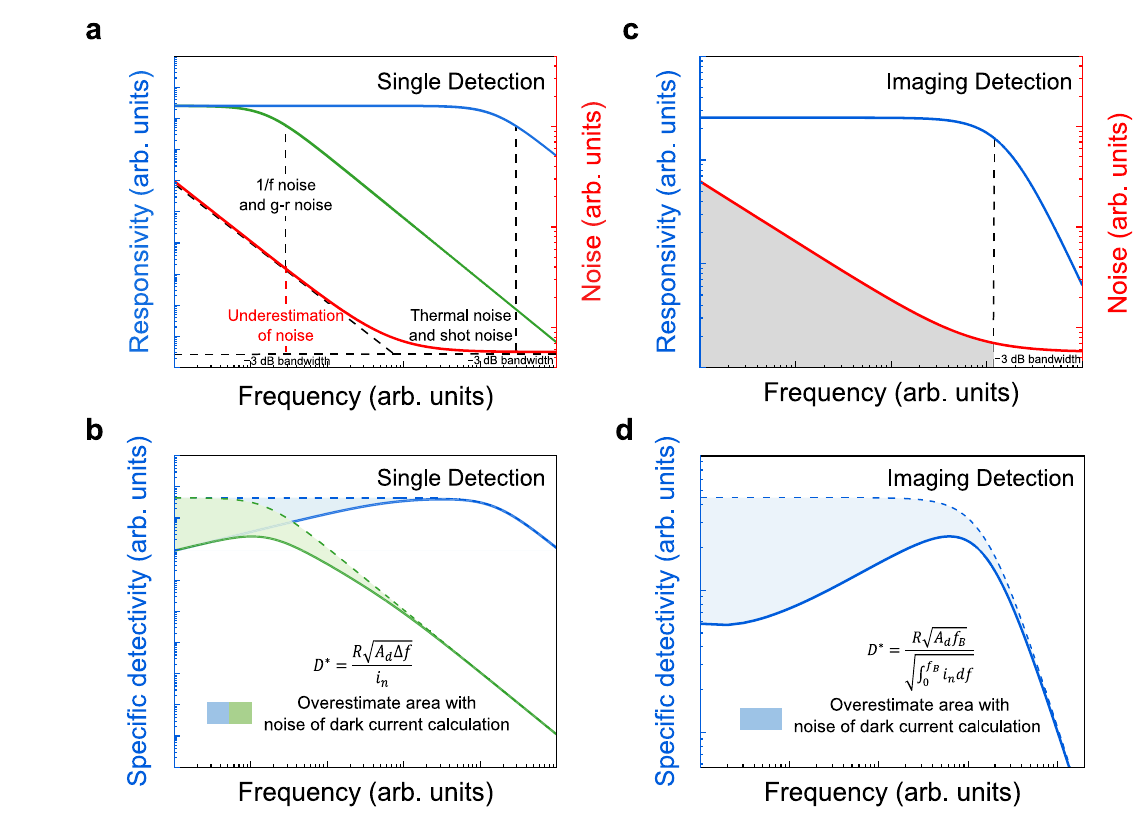
Fig. 5 | Impact of different noise conditions on D* in scenarios of single detection and imaging detection. a Noise and responsivity characteristics for photodetectors with different response bandwidths for single detection (the blue line represents the typical responsivity curve of photodetectors of high response bandwidth, the green line represents the typical responsivity curve of photo- detectorsoflow responsebandwidth,and thered line representsthetypicalnoise characteristics. The vertical dashed lines represent the − 3dB bandwidth for pho- todetectors with high and low response bandwidth). b Overestimation of speci fi c detectivity based on noise characteristics for single detection. The solid and